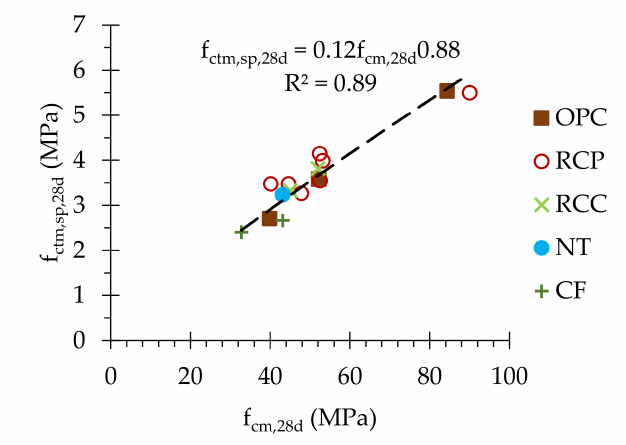
Figure 18. Tensile splitting strength at 28 days, f ctm , sp ,28 d , as a function of compressive strength at the same age , f